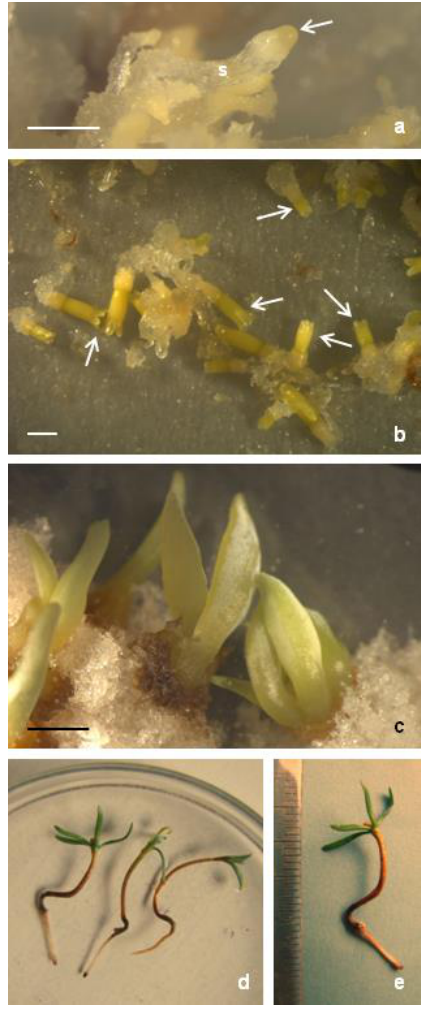
Figure 4. Somatic embryo maturation in Abies alba : ( a ) precotyledonary somatic embryo with apparent embryonal part (arrow) and suspensor (s) anchored in embryogenic tissue; ( b ) cotyledonary somatic embryos (arrows) developed on a maturation medium, approximately after eight weeks of cultivation; ( c ) abnormally developed structures with overproliferated tissue; ( d , e ) regenerated plantlets (somatic seedlings). Bars: ( a , b ) 000 µm; ( c ) 2000 µm.